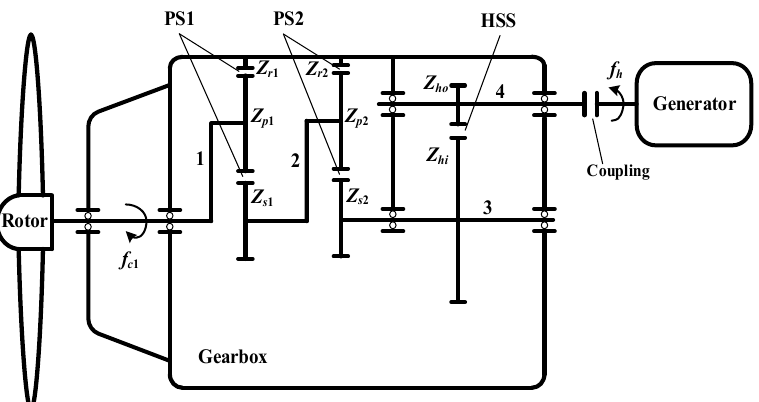
Figure 4. Structure of wind turbine gearbox with two planetary stages and one parallel stage: 1—planet carrier of the first planetary stage; 2—planet carrier of the second planetary stage; 3—the second sun shaft; 4—high-speed shaft.